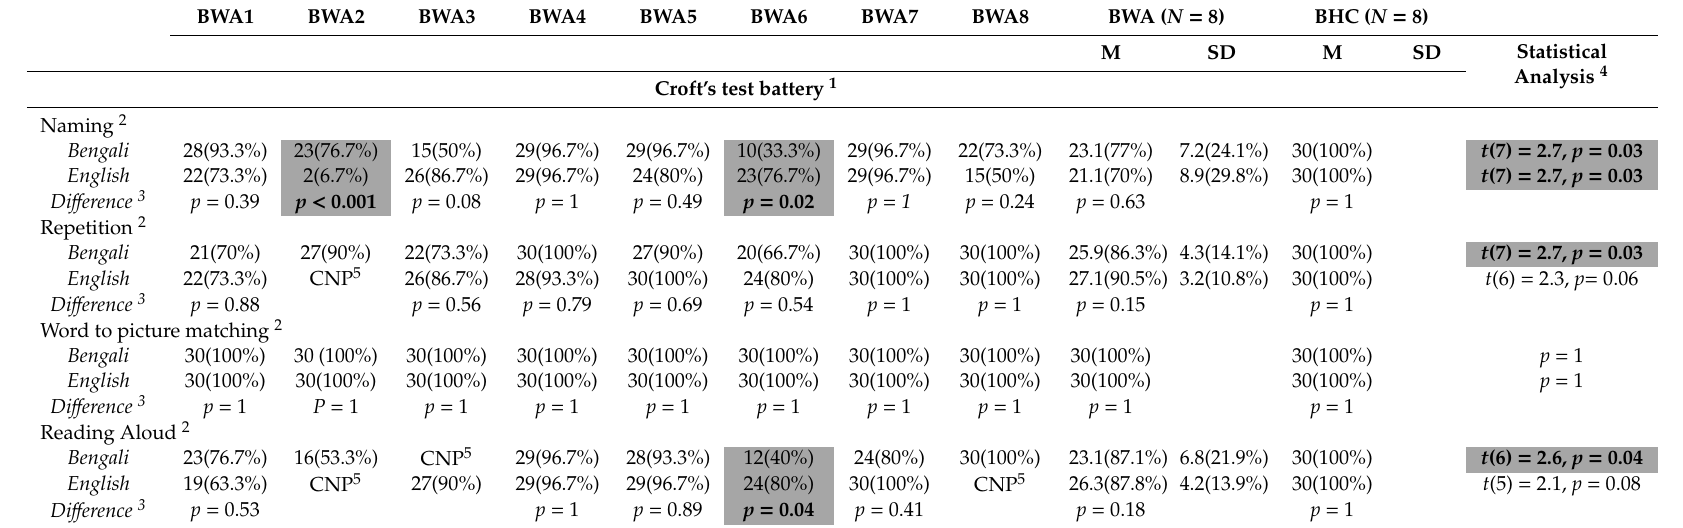
Table A2. Accuracy (raw score and %) in language background test of BWA using Croft’s Test Battery.